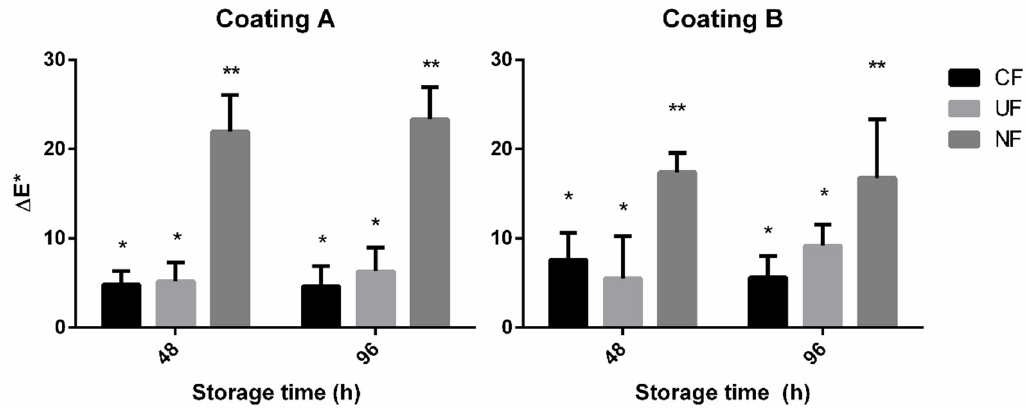
Figure 6. Colour difference between poultry samples treated with (CF) coated PP film, (UF) uncoated PP film, (NF) no film. Coating A = 5 wt% P. dioica extract and 7.5 wt% PVA. Coating B = 1 wt% P. dioica extract, 1 wt% PVA, and 17 wt% gelatine. Results presented as the average of three readings of three samples (n = 3). * and ** Identify statistically identical results, with p < 0,01, determined by Tukey’s HSD.